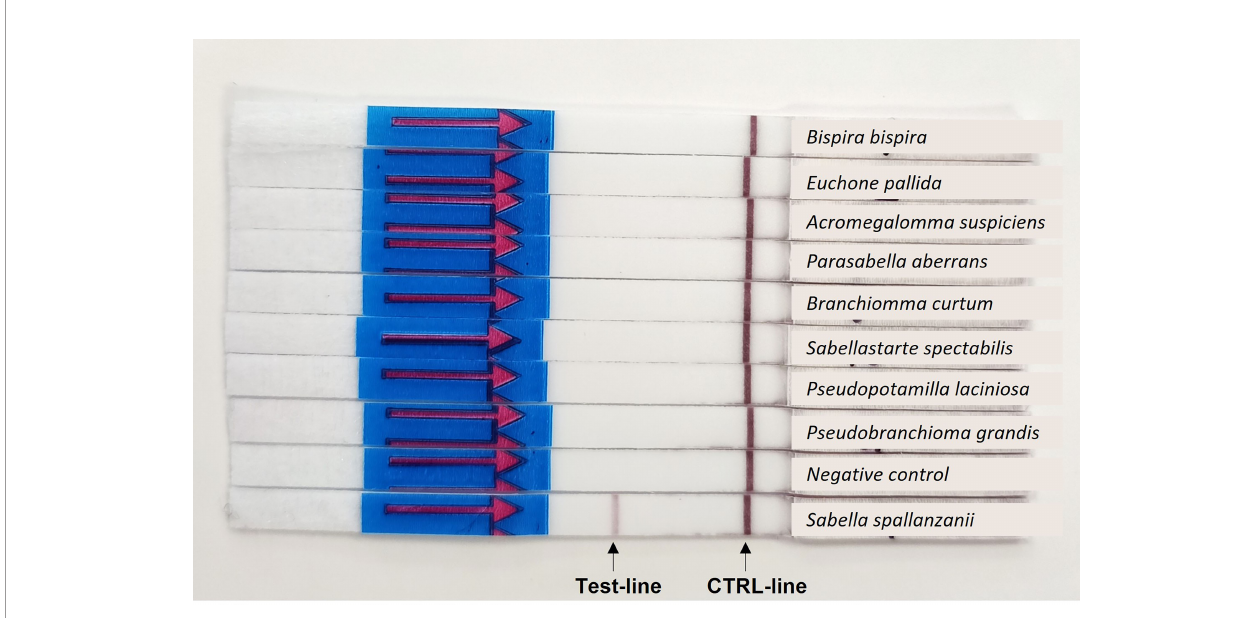
FIGURE 3 | Results of the speci fi city testing: Positive ampli fi cation is indicated by a colored band in the test-line and a colored band in the control (CTRL)-line.